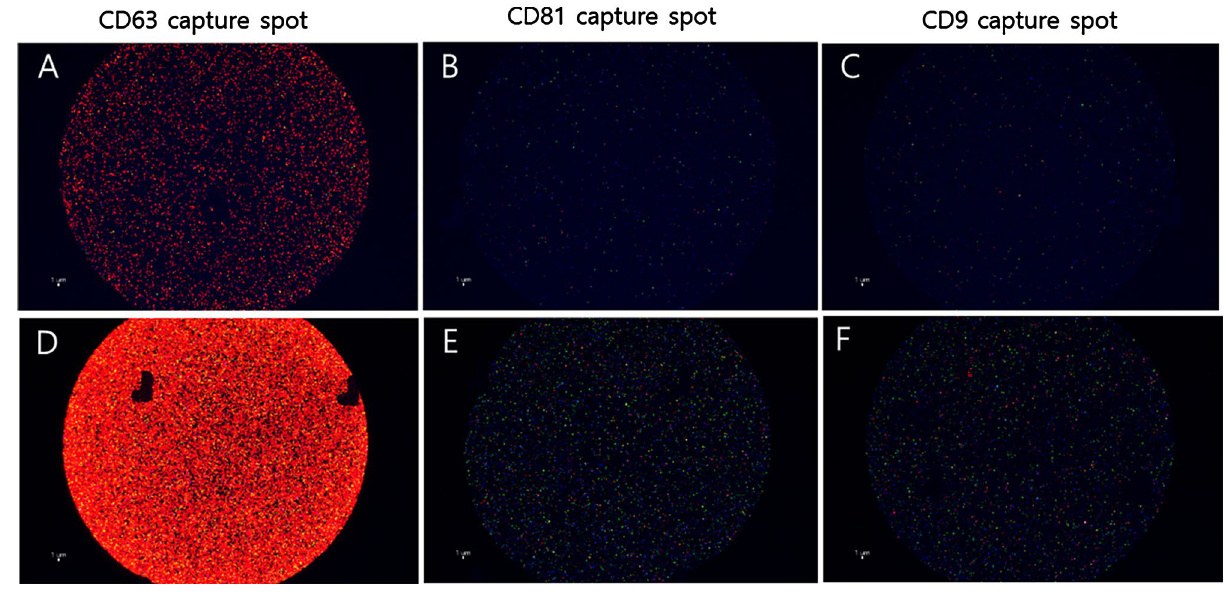
Figure 4. Representative capture spot images including CD63, CD81, and CD9 in ( A – C ) control subjects and ( D – F ) PEX patients are visualized. Compared to the control subjects ( A – C ), the number of the exosome particles in PEX patient AH samples ( D – F ) was higher. In addition, among each tetraspanin capture antibody detected in each capture spot, CD63 (red color) was present in the highest numbers of the exosomes, followed by syntenin (green color) and CD9 (blue color). In particular, syntenin with a green-colored capture antibody was detected in all three capture